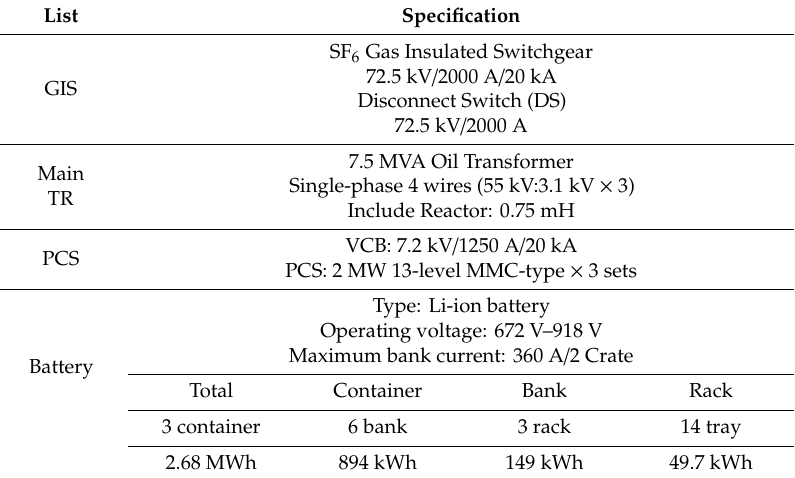
Table 4. Demonstration System Specification.